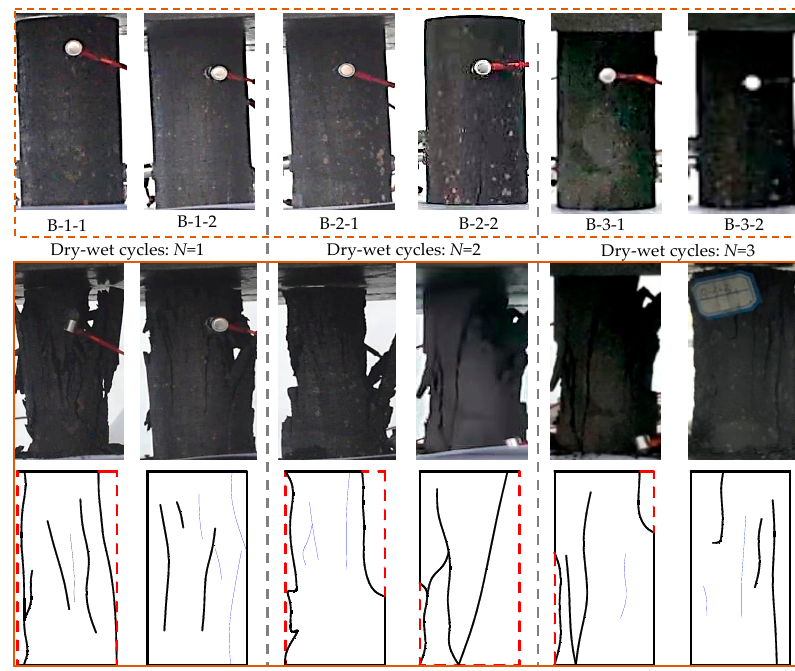
Figure 10. Failure patterns of coal samples at various drying–wetting circles.